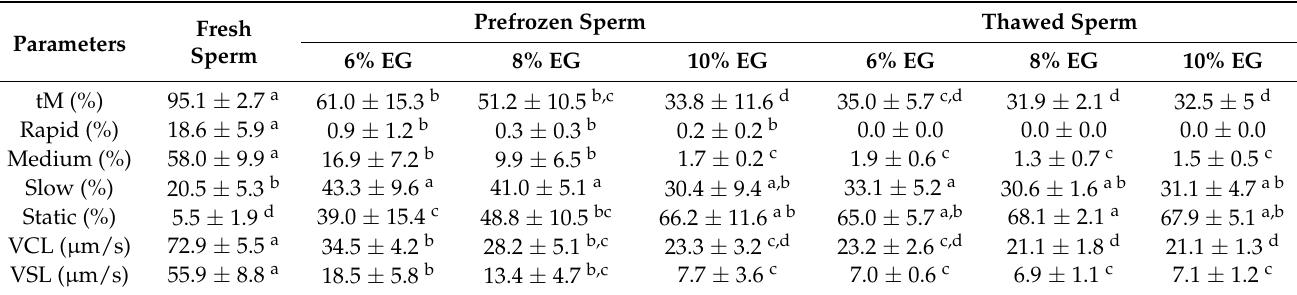
Table 1. Total motility (tM), motility types (rapid, medium, slow, static), and sperm velocities in fresh, prefrozen (fresh sperm diluted), and frozen-thawed sperm from S. cuspicaudus with different inclusion percentages (6, 8, and 10%) of ethylene glycol (EG). Different letters indicate differences ( p < 0.05). VCL, curvilinear velocity; VSL, linear sperm